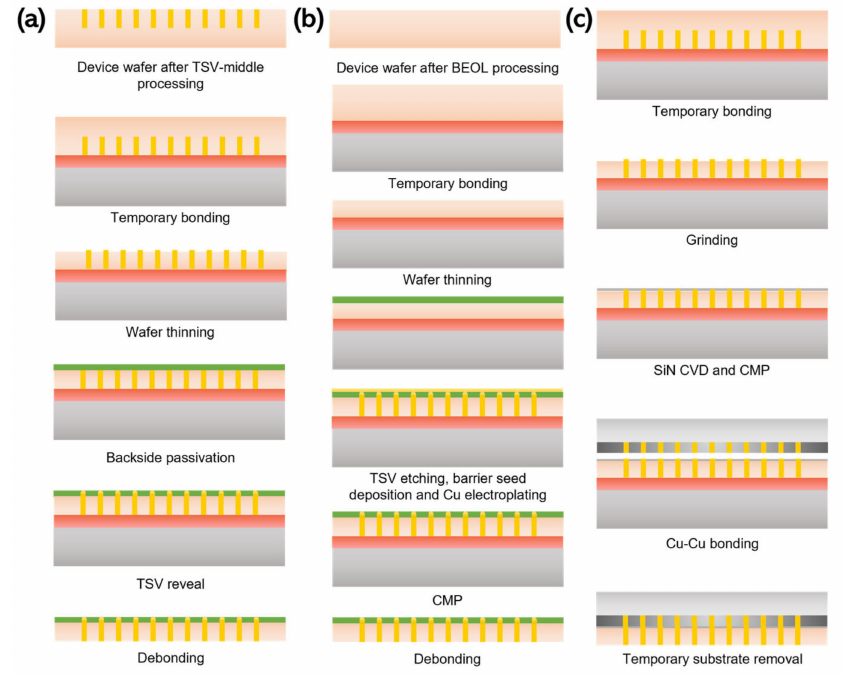
Figure 4. Three manufacturing processes of TSV: via-middle ( a ); via-last ( b ); Cu-Cu bonding ( c